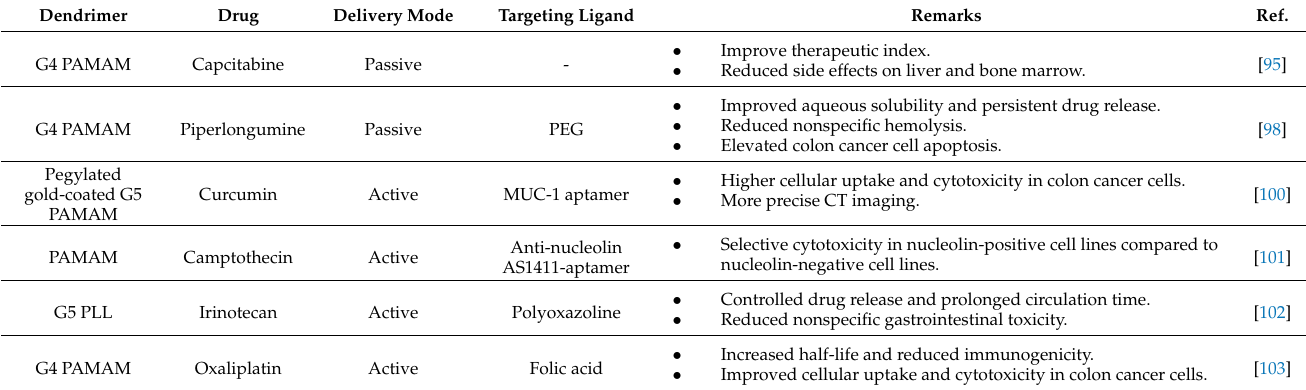
Table 1. Recent trials in dendrimer-mediated targeting of anticancer drugs for the treatment of colon